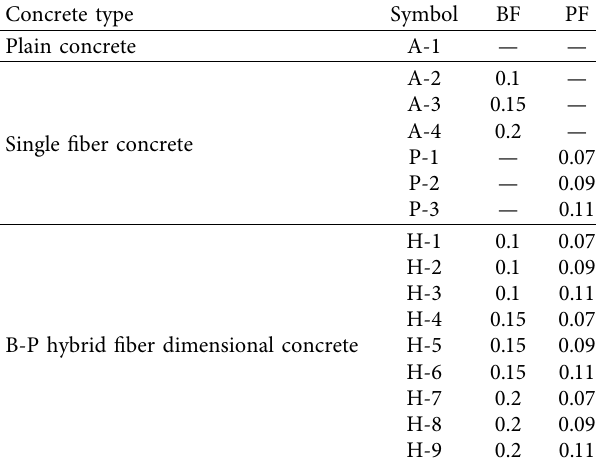
Table 2: Volume rate of fibers (%).